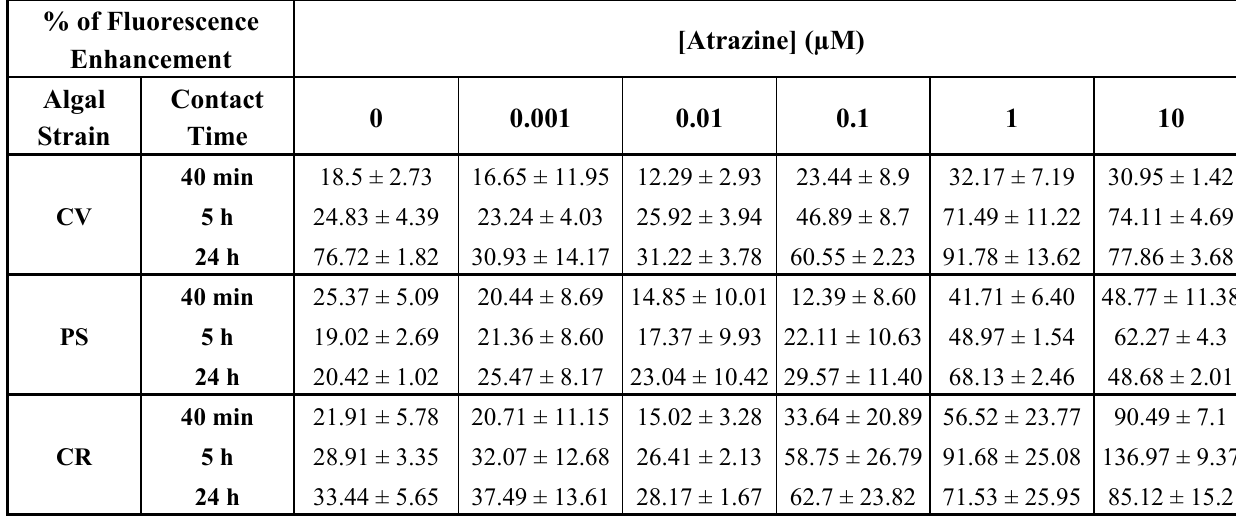
Table 2. % of chlorophyll fluorescence enhancement after contact with atrazine (0 to 10 µM) on algae entrapped within silica hydrogels according to different contact times (40 minutes, 5 hours and 24 hours). Three algal strains were used: C. vulgaris (CV), P. subcapitata (PS) and C. reinhardtii